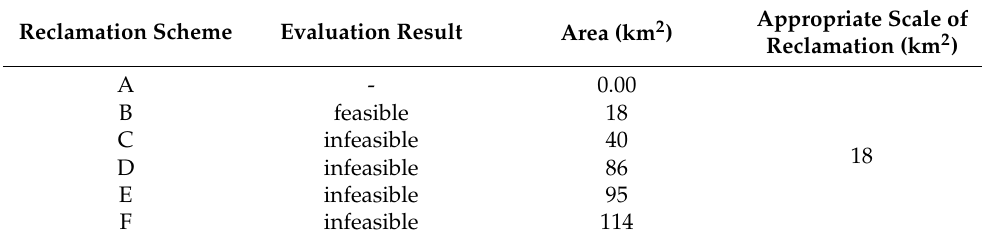
Table 10. The maximum allowable area for CR in Haizhou Bay (scenario 1).